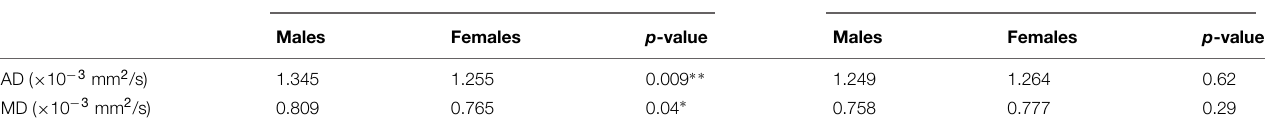
TABLE 3 | Summary of multiple linear regression models predicting performance on the acquisition and reversal phases of the IGT.